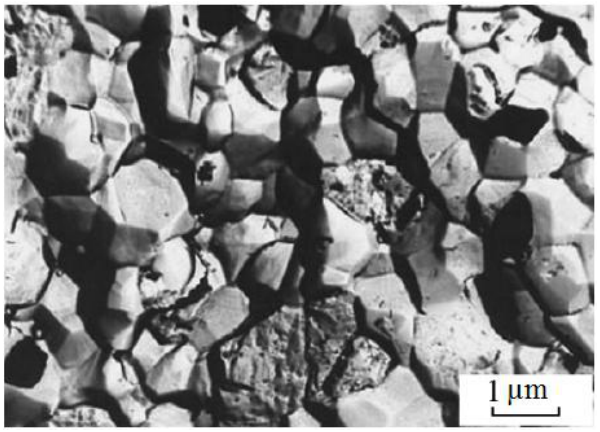
-3% Y O sample sintered at 1450 °C and 40 2 2 3